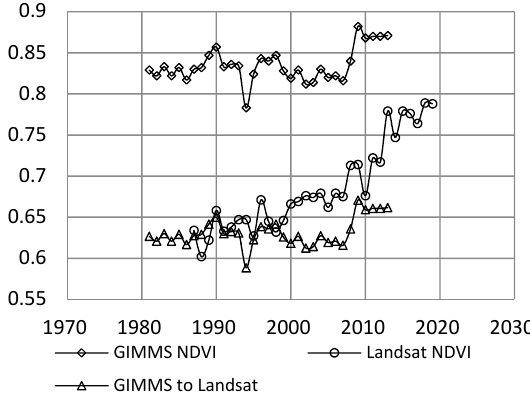
Figure 2. Time change sequence diagram of GIMMS and Landsat NDVI in Qinling Mountains.